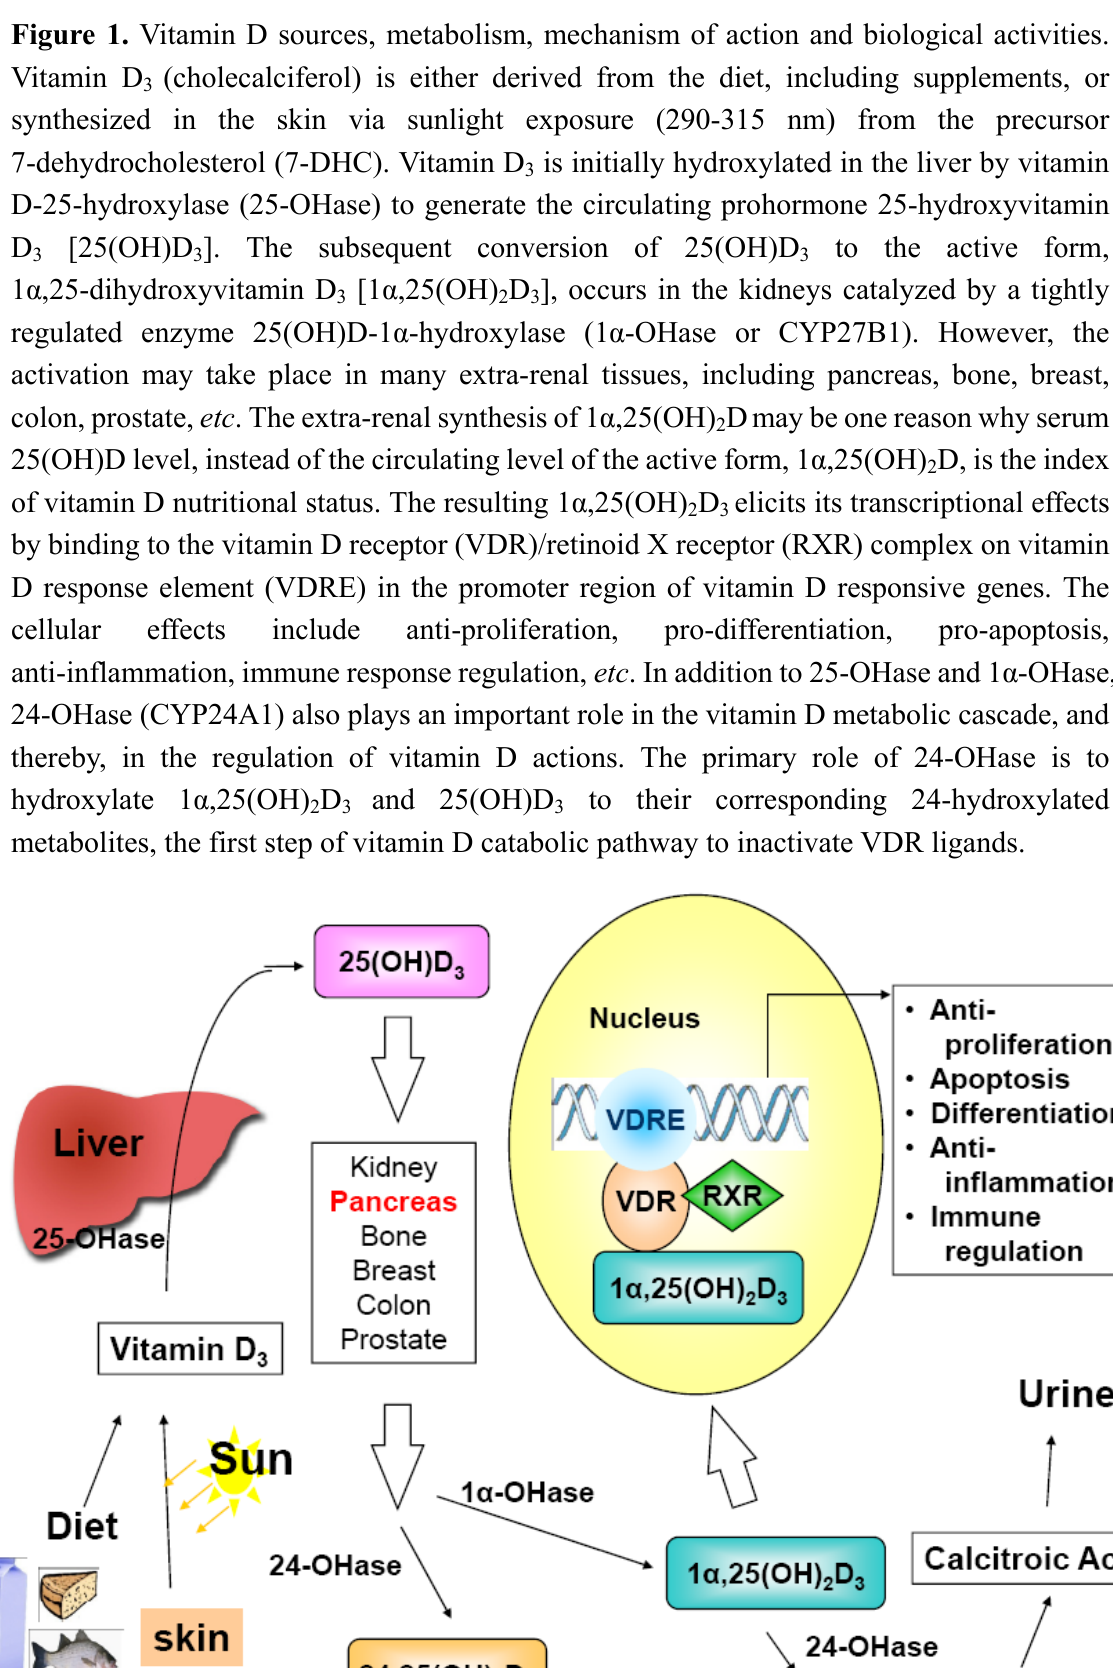
Figure 1. Vitamin D sources, metabolism, mechanism of action and biological